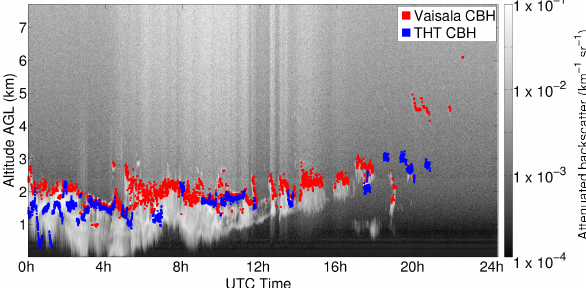
Fig. 1. Ceilometer attenuated backscatter image at Princess Elisa- beth (14 March 2011) on a logarithmic scale. Red dots represent the CBH calculated by the built-in Vaisala algorithm. Blue dots rep- resent the CBH calculated by the THT